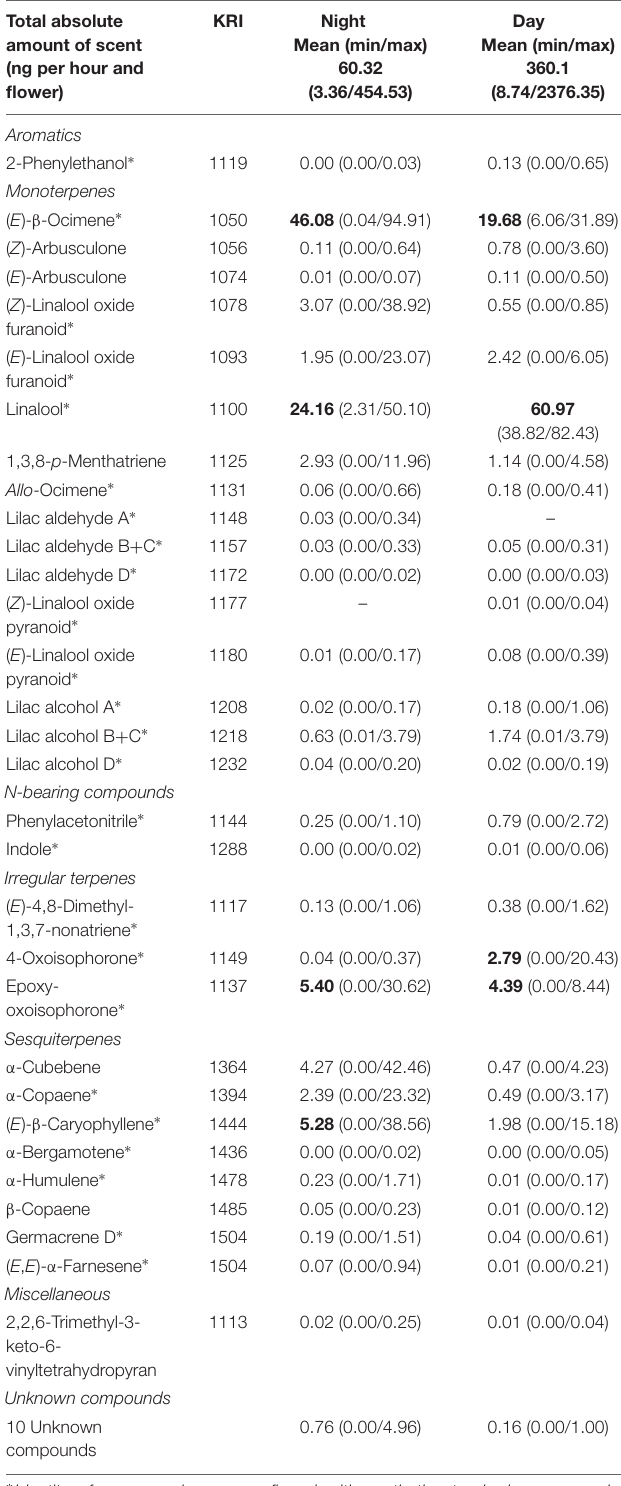
TABLE 1 | Mean (minimum, maximum) total absolute and relative amount of each compound detected in the night and day floral scent samples of Paullinia cupana var. sorbilis ( N = 13